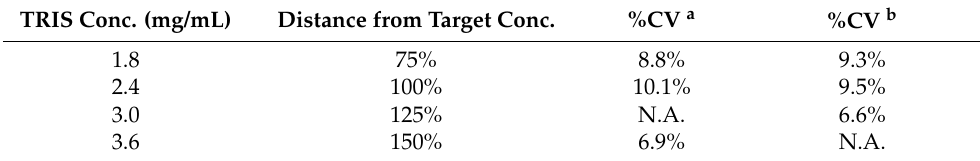
Table 4. Range analysis expressed as repeatability at 75% − 125% of the TRIS target concentration. TRIS Conc.